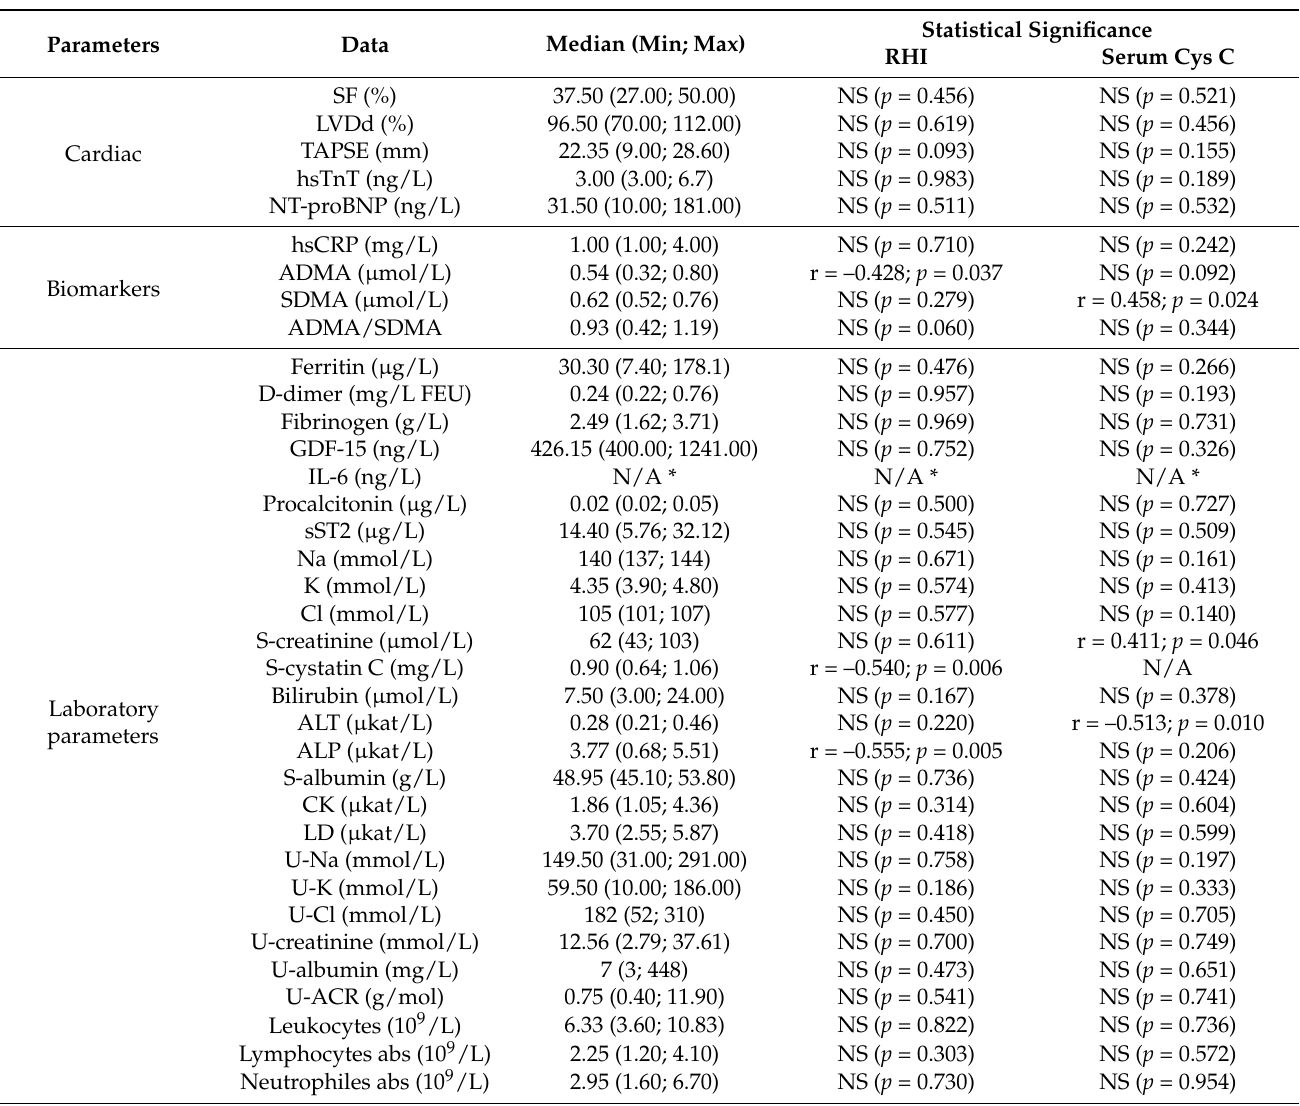
Table 6. MIS-C: biomarkers, cardiac, and laboratory parameters, and correlations with RHI and Cys